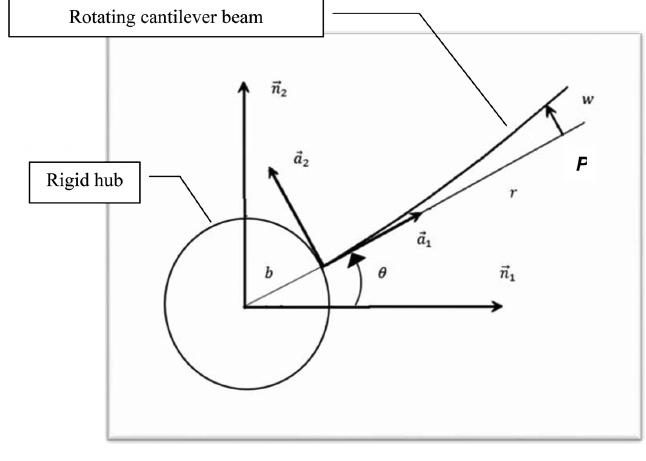
Fig. 1. Rotating cantilever